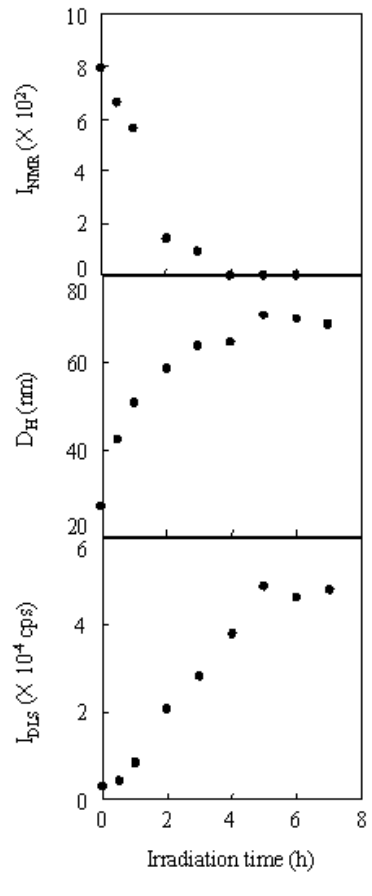
), and scattering intensity (I H